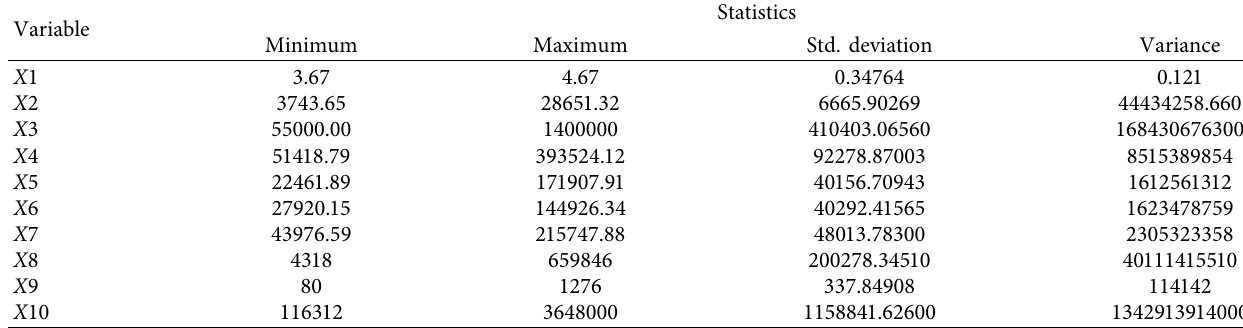
Table 1: Statistical description of X variable related to DMU1.